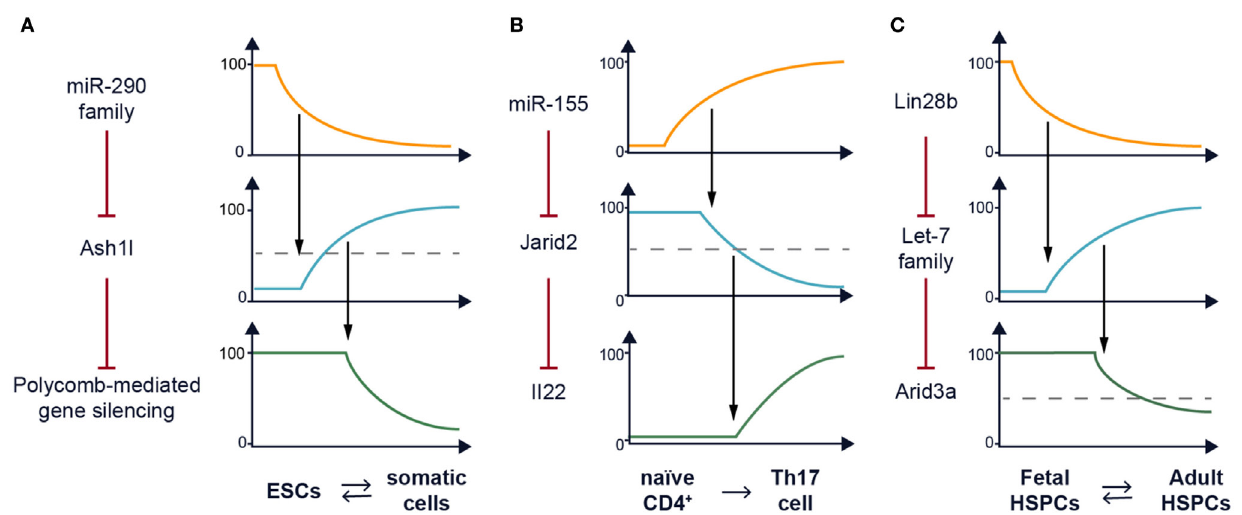
FigURe 1 | Recurrent network motif in posttranscriptional (re)programming. (A) The miR-290–Ash1l–polycomb repressive complex 2 (PRC2) axis plays a role in setting the chromatin landscape of embryonic stem cells (ESCs) to support the pluripotency gene expression program. A model of how the expression of the miR-290 family and Ash1l varies to impact activity of PRC2 is depicted along a time course as ESCs undergo differentiation. This process is reversible (7–9). (B) The miR-155–Jarid2 axis can also remodel the chromatin landscape by regulating PRC2 recruitment to support the Th17 gene expression program including transcription of the Il22 cytokine gene among many others. A model of how the expression of miR-155 and Jarid2 varies to impact Il22 transcription is depicted along a time course as naïve CD4 + T cells undergo Th17 differentiation. This process has not been shown to be reversible. (C) The Lin28b–let-7 axis mediates the fetal–adult hematopoietic switch. One downstream target of this pathway in B cell lineage progenitors is Arid3a messenger RNA which encodes a transcription factor (10). A model of how the expression of Lin28b and the let-7 family varies to impact Arid3a posttranscriptionally is depicted for hematopoietic stem and progenitor cells (HSPCs) during ontogeny. This process is reversible